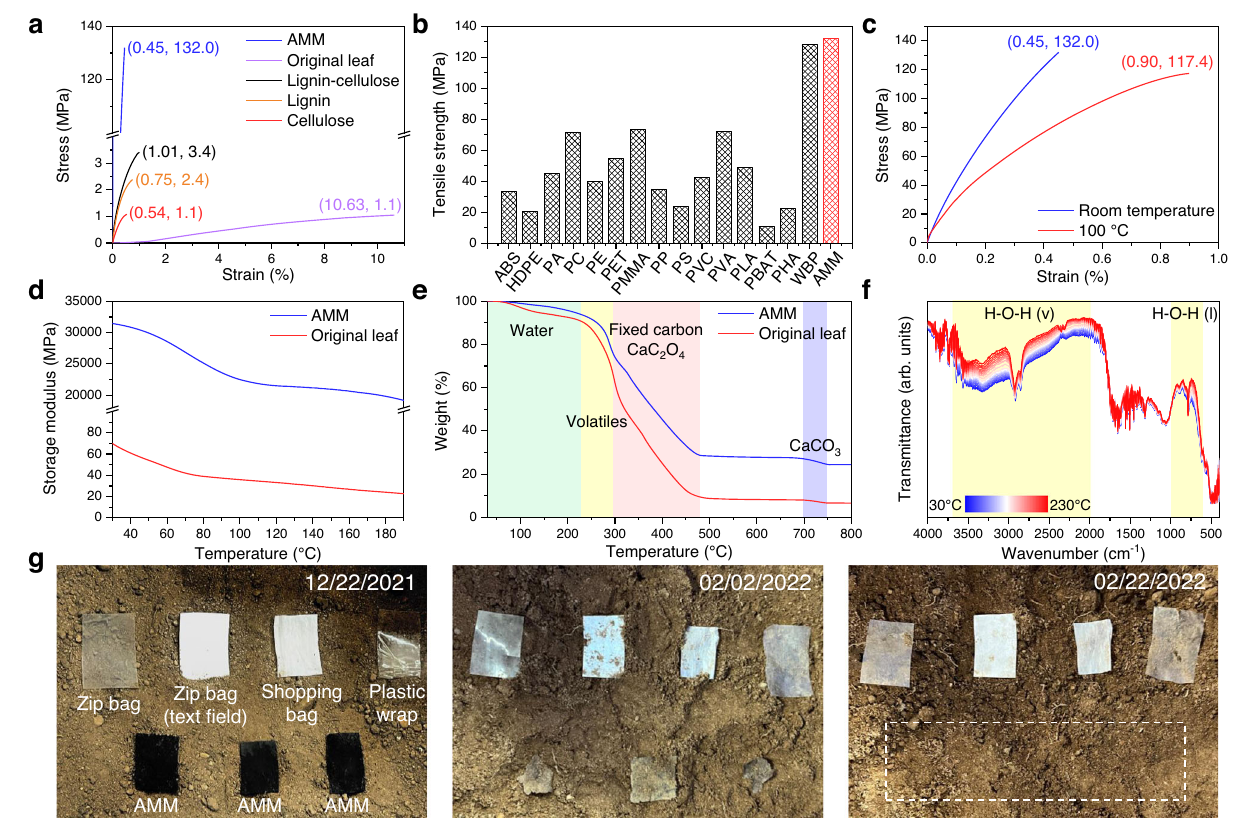
Fig.7|ApplicationoftheAMM fi lmasabioplasticanditsmechanical,thermal, and biodegradation properties. a Stress ‒ strain curve of the AMM in comparison with those for its components and the original leaf. b Comparison of the tensile strengths of AMM, wood-derived bioplastic (WBP), and petroleum-based plastics including acrylonitrile butadiene styrene (ABS), high-density polyethylene (HDPE), polyamide(PA),polycarbonate(PC),polyethylene(PE),polyethyleneterephthalate (PET), polymethyl methacrylate (PMMA), polypropylene (PP), polystyrene (PS),